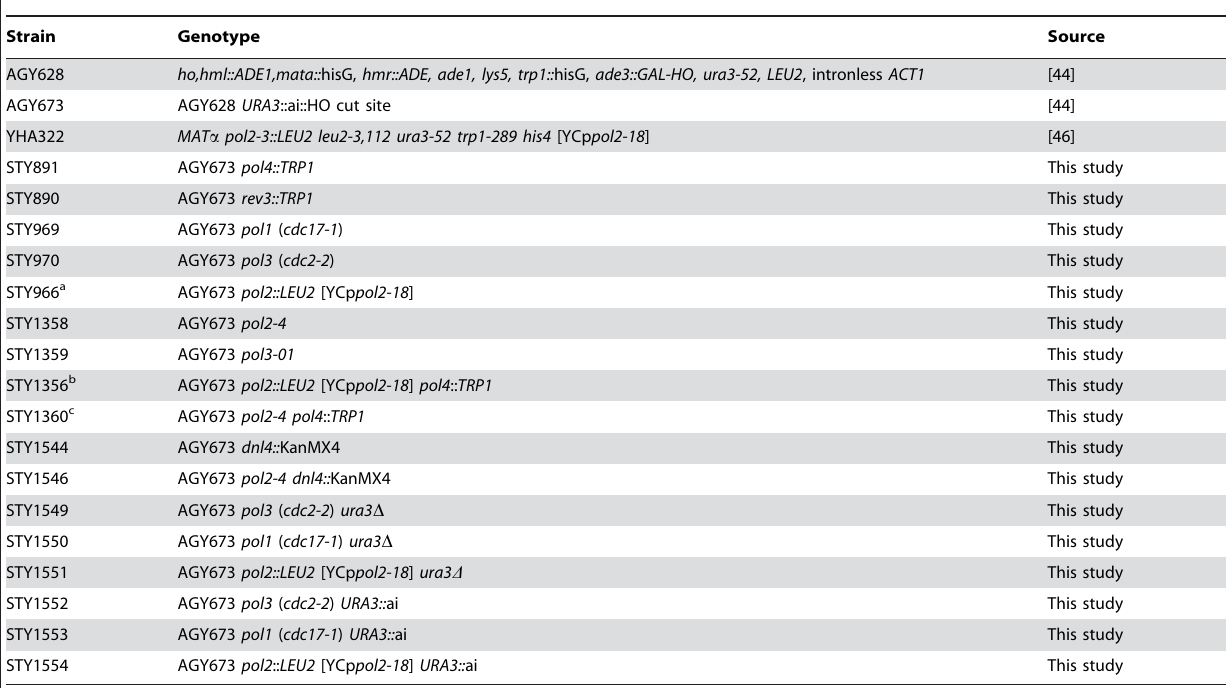
hypothesis that the 3 9 to 5 9 exonuclease activity of Pol2 is involved in the processing step that degrades the 3 9 flaps to create the 2 3 end joining product. Further, we confirmed that the events we observed in the pol2-4 strain were in fact due to NHEJ. We compared survival in isogenic dnl4 and pol2-4 dnl4 yeast cells relative to the wild type and pol2-4 strains (Figure 2 and Table S1), and found an , 100 fold drop in the absence of dnl4 , a key component of the NHEJ pathway. Of note, we also observed that Table 3. Yeast strains used in this study.